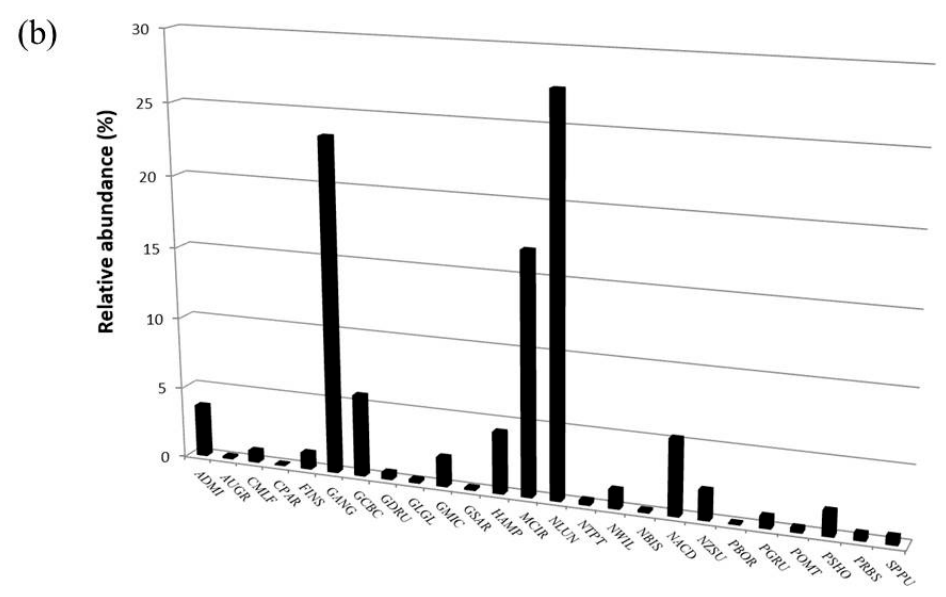
Environments 2021 , 8 , x FOR PEER REVIEW 11 of 16 Figure 2. Relative abundance of the diatom species found at least once in one sample for: ( a ) Pilato lake; ( b ) Palazzo Borghese Lake. Table 2. List of the 111 species of diatoms recognized in the Pilato and Palazzo Borghese lakes in 2019. For the species for which they are available, the values of diatomic indices IPS [27] and TI [28], and the threatened status according to Lange-Bertalot Red List criteria [40] were reported. The different quality classes are indicated with the following colours: light blue = Class I (High); green = Class II (Good); yellow = Class III (Moderate); orange = Class IV (Poor); red = Class V (Bad). 2 = severely endangered (species showing significant population decline or subject to substantial threat caused by human impact); 3 = endangered (species showing a significant population decline or one that is probably threatened by human impact); G = at risk (threatened species, but available information is not sufficient to allow an assignment to cat- egories 1 to 3); Z = not classified; ? = not threatened (species populations have increased, are stable or have decreased slightly); * = currently not considered threatened V = decreasing (species displaying a substantial population decline but not yet considered as threatened); R = extremely rare (extremely rare species for which there are only one to six records); D = data deficient (information on the distribution, biology or level of threat is insufficient).